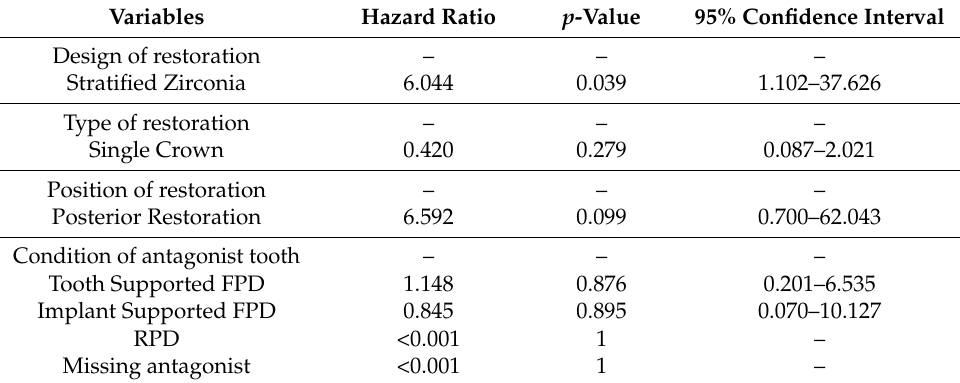
Table 4. The results of the Cox